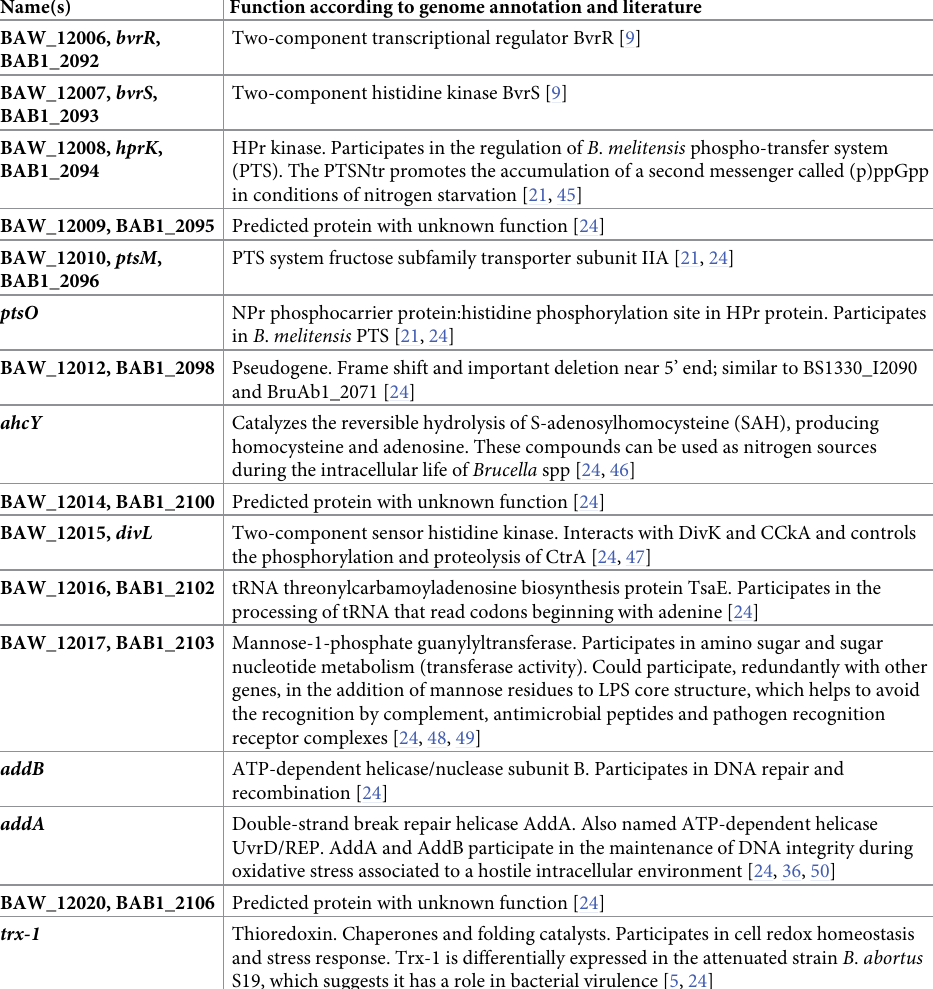
Table 1. Description of the 16 genes that belong to bvrR/bvrS operon in B . abortus 2308W and correspondence with B . abortus 2308